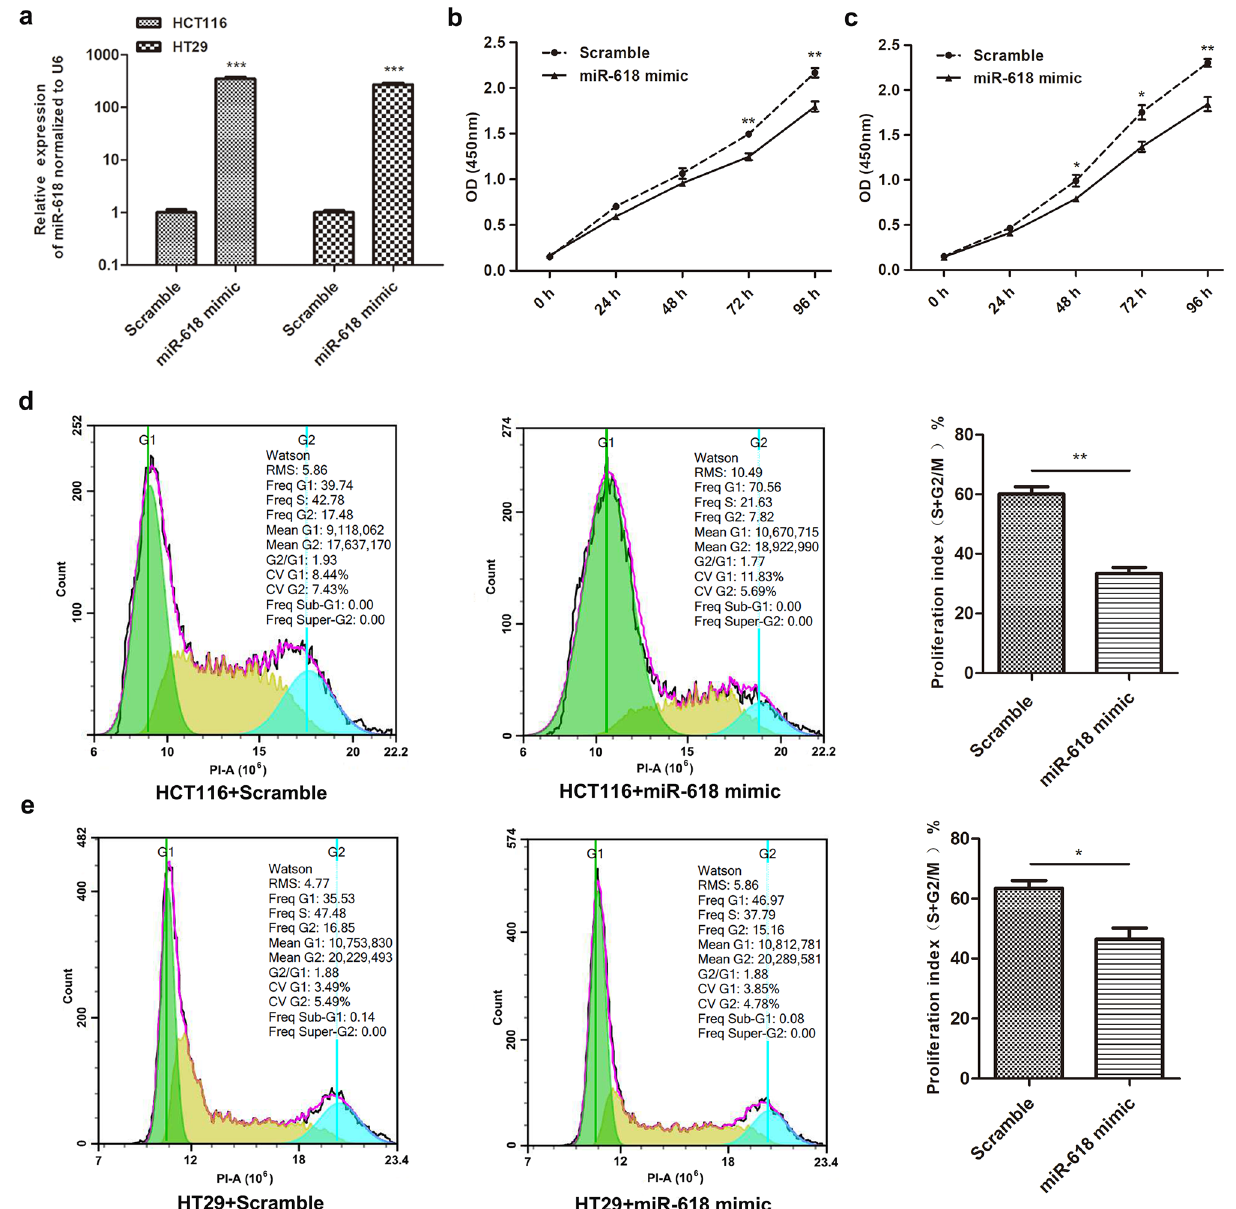
Figure 2. miR-618 suppresses the proliferation of colon cancer cell lines. ( a ) q-PCR analysis of miR-618 in HCT116 and HT29 cells after transfecting miR-618 mimic or Scramble. *** P < 0.001 (t-test). ( b ) Growth curves of HCT116 cells transfected with miR-618 mimic or Scramble. ** P < 0.01 (t-test). ( c ) Growth curves of HT29 cells transfected with miR-618 mimic or Scramble. * P < 0.05, ** P < 0.01 (t-test). ( d ) Flow cytometry analysis of cell cycle of HCT116 cells transfected with miR-618 mimic or Scramble. ** P < 0.01 (t-test). ( e ) Flow cytometry analysis of cell cycle of HT29 cells transfected with miR-618 mimic or Scramble. * P < 0.05